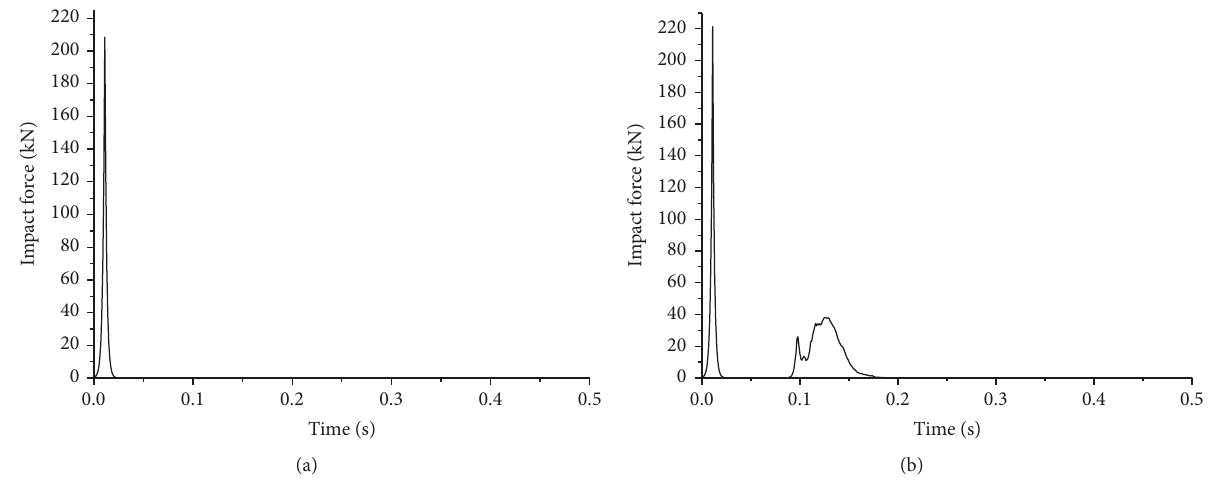
Figure 4: Impact force of the two models: (a) control model and (b) reinforced model.